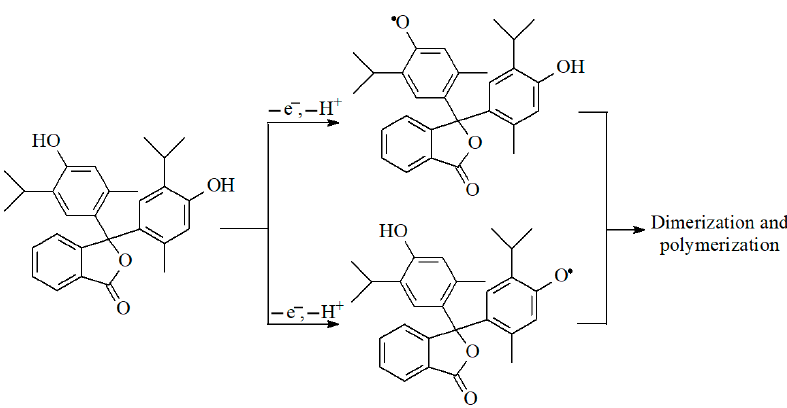
Scheme 1. Electrooxidation of thymolphthalein.